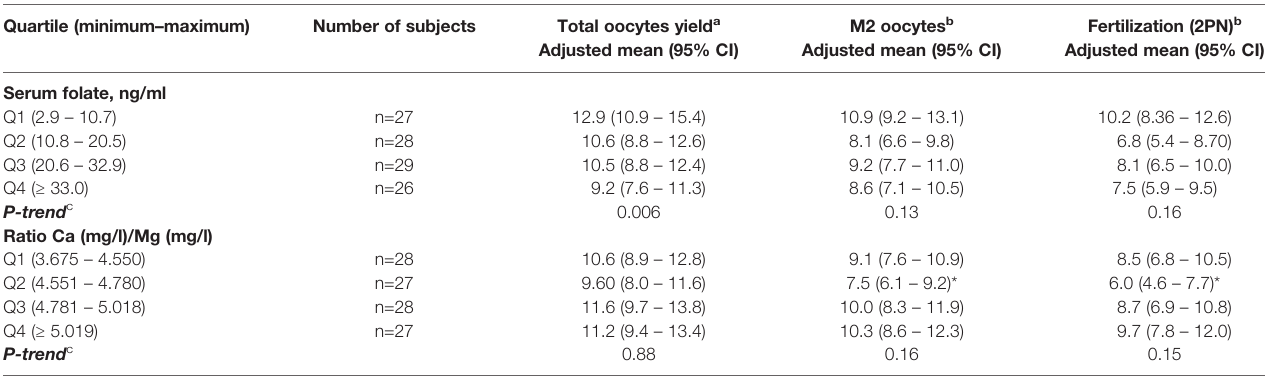
Adjusted mean (95% CI)